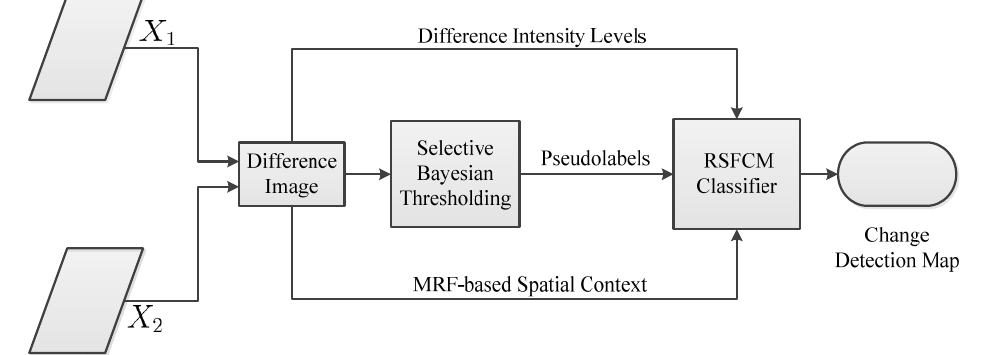
Figure 1. Flowchart of proposed change detection approach based on robust semi-supervised fuzzy C-means (RSFCM).